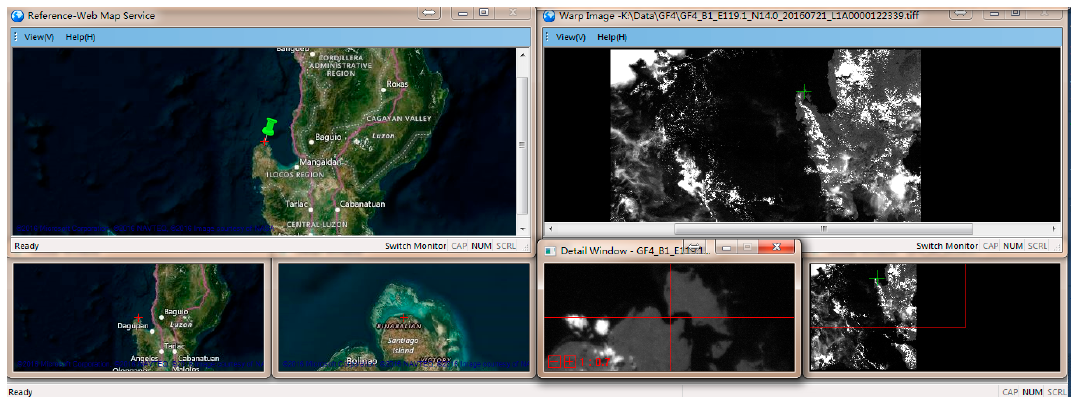
Figure 8. This is a GCP prediction result. In the main window of the wrap image (top-right window), the selected point is denoted by a green cross mark, while the predicted point is denoted by a green pushpin in the main window of the online map service (top-left window). The predicted GCP was located in the same small island where the Level 1 image was clicked (see the two adjacent detail windows).